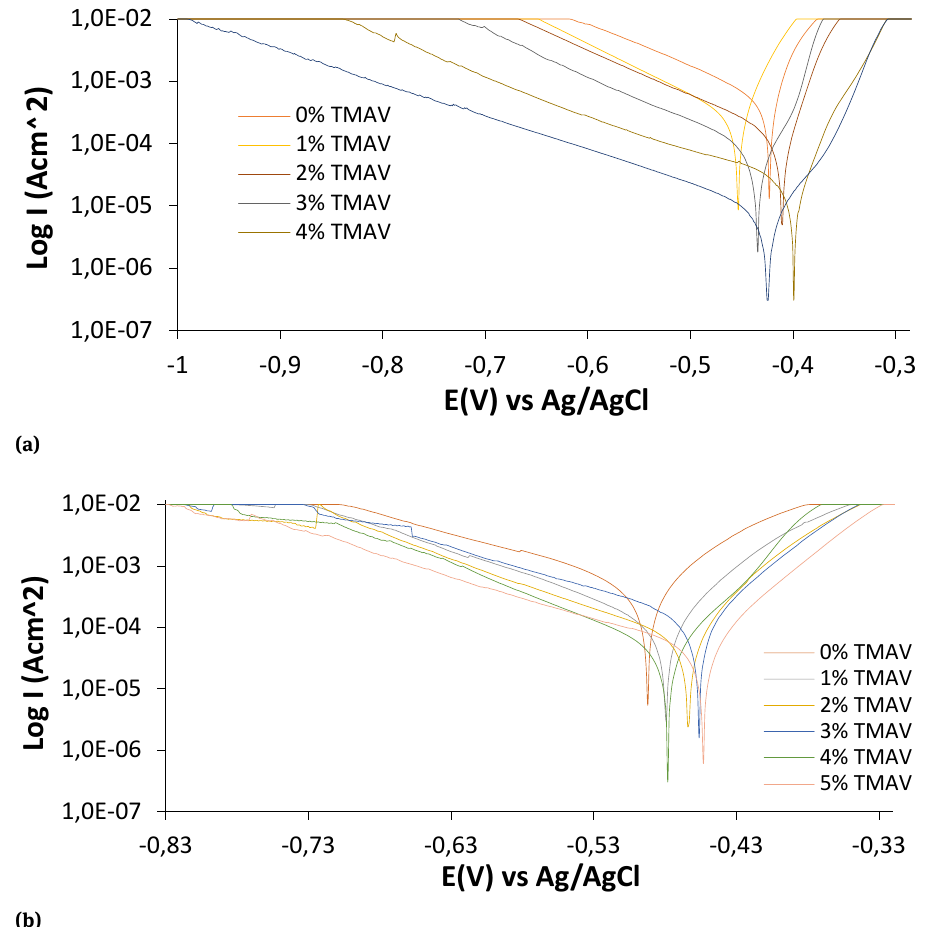
Figure 1: LCS potentiodynamic polarization plots in (a) 0.5 M H 2 SO 4 solution and (b) 0.5 M HCl solution at specific TMAV